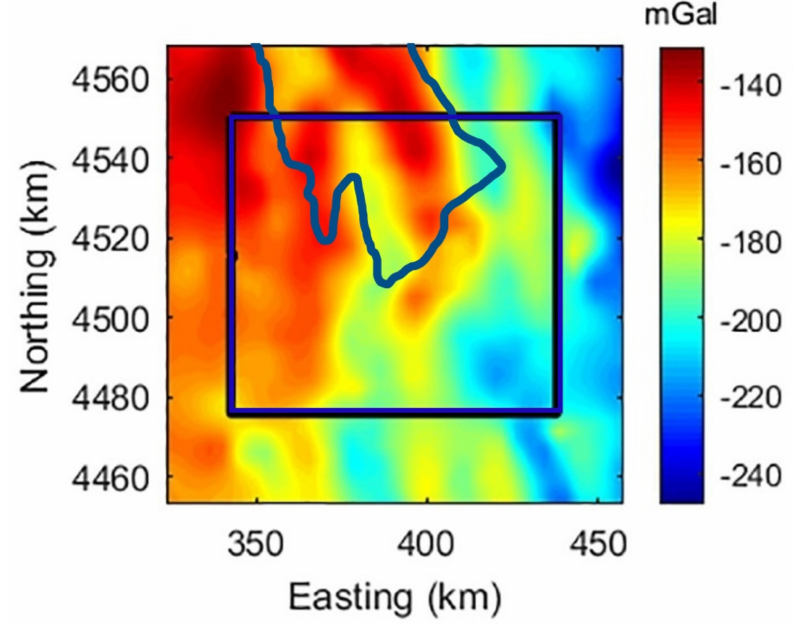
Figure 3. Bouguer gravity anomaly located in the central part of the state of Utah. A rectangle shown by the solid black line outlines the area of interest (AOI). The dark blue line shows the contour of Great Salt